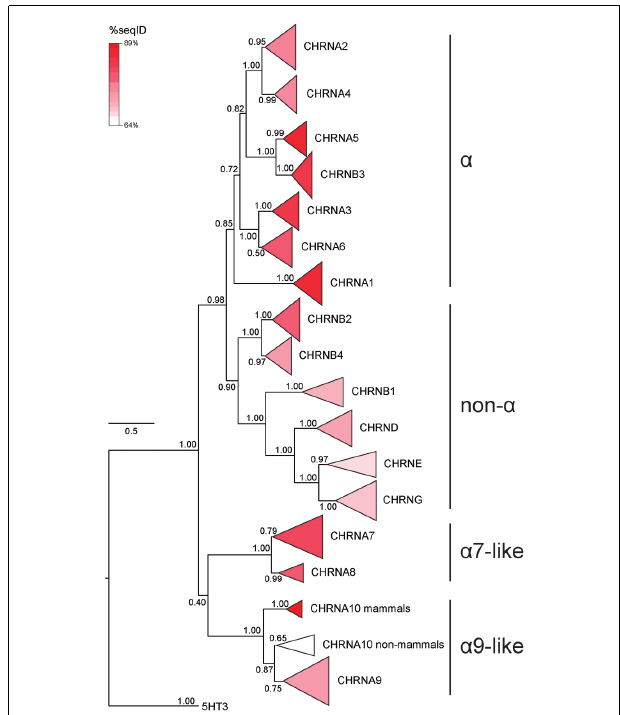
FIGURE 3 | Phylogenetic tree showing the relationships between vertebrate nicotinic subunits. The branches corresponding to the same subunits of different species were collapsed to their respective node. The length of each triangle denotes sequence divergence from the corresponding node. Triangle shades depict the average sequence identity within the branch. Numbers in each branch indicate bootstrap values obtained during phylogeny construction. The scale bar indicates the number of amino acid substitutions per site. Modified from Marcovich et al. (2020), under the Creative Commons license